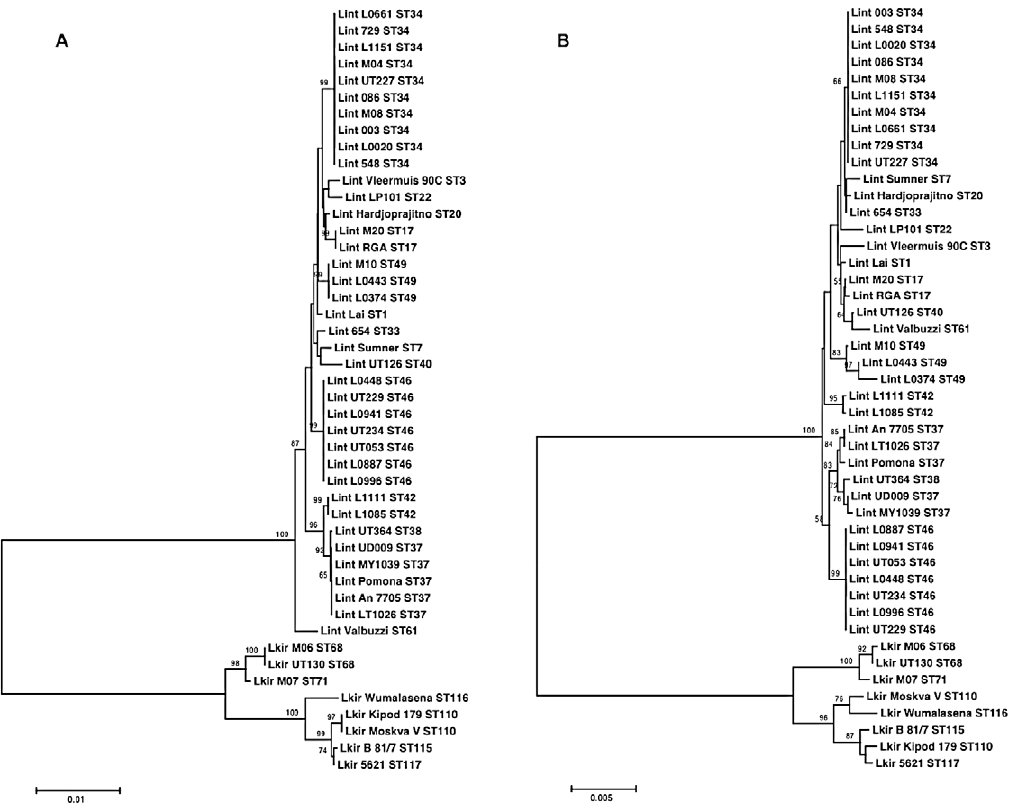
Figure 2. Neighbor joining trees of the 7L scheme and the 6 loci scheme. Neighbor joining trees reconstructed based on concatenated sequences of the 7L scheme (3,165 bp) (A), and the 6 loci scheme (2,844 bp) (B). Each bacterial strain is labeled by the following string: abbreviation of species name (Lint- L. interrogans , Lkir- L. kirschneri ), strain name, and (for the 7L scheme only) sequence type (ST).